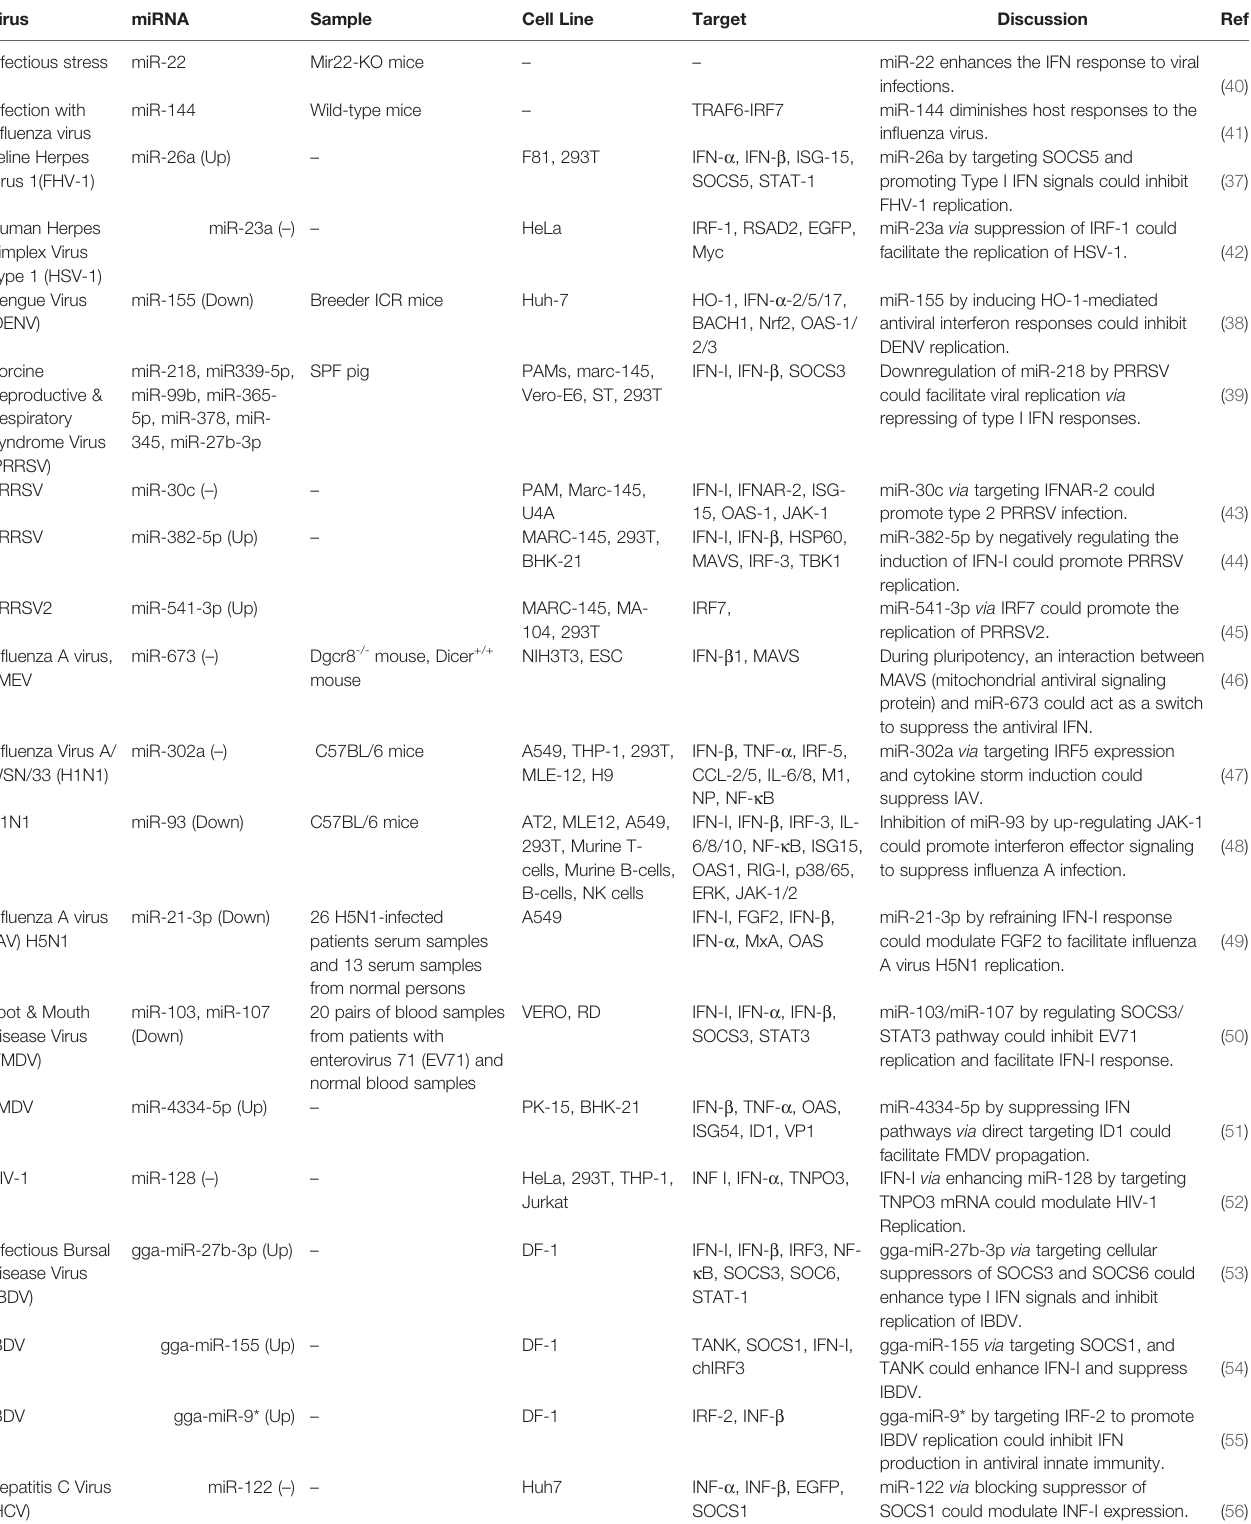
TABLE 2 | The effects of miRNA on IFN signaling in the context of viral